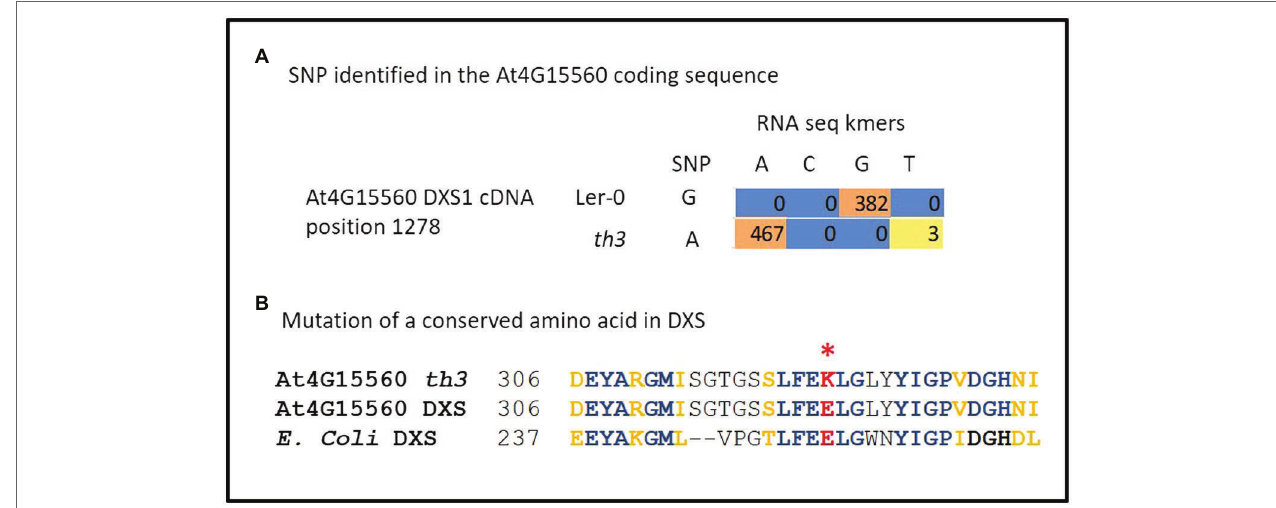
FIGURE 2 | The th3 genome carries a mutation in DXS1 . (A) Identification of a G to A mutation in At4G15560 encoding DXS1. Coding sequences of all genes located on chromosome 4 were scanned for SNPs using triplicate RNA-seq data from th3 mutant and wild-type Ler-0 plants grown on 30 nM thiamin. The table shows counts of kmers representing A and G variants in Ler-0 and th3 detected at position 1278 in the full-length cDNA sequence. (B) The th3 associated SNP converts a highly conserved glutamate residue at position 323 in DXS1 sequence to a lysine. The context of the substitution is shown in a partial alignment of Arabidopsis and E. coli DXS protein sequences. Identical (blue) and similar (gold) amino acids are highlighted in bold. A non-conservative glutamate to lysine substitution in DXS1-th3 is highlighted in